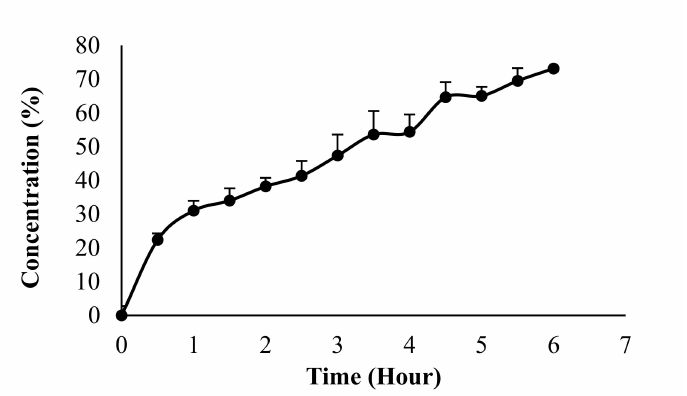
Figure 6. In vitro drug release of a-M/EtOH Alg/Chi-HF. Each value represents the mean ± SD of three experiments.